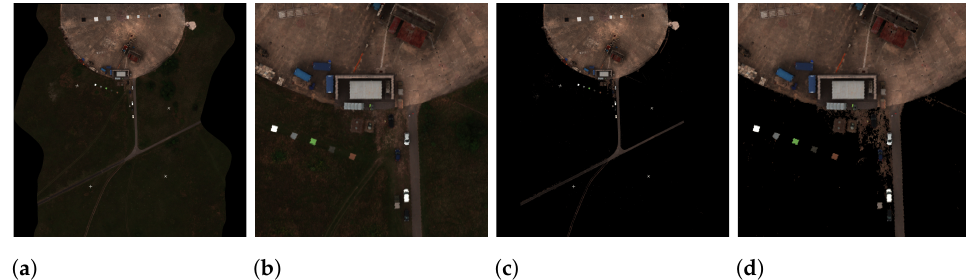
Figure 14. Example image from the UDRC Selene Dataset. ( a ) False colour image of the target area. ( b ) Enlarged version of ( a ). ( c ) Retained pixels following the NDVI re spatial masking. ( d ) Enlarged version of ( c